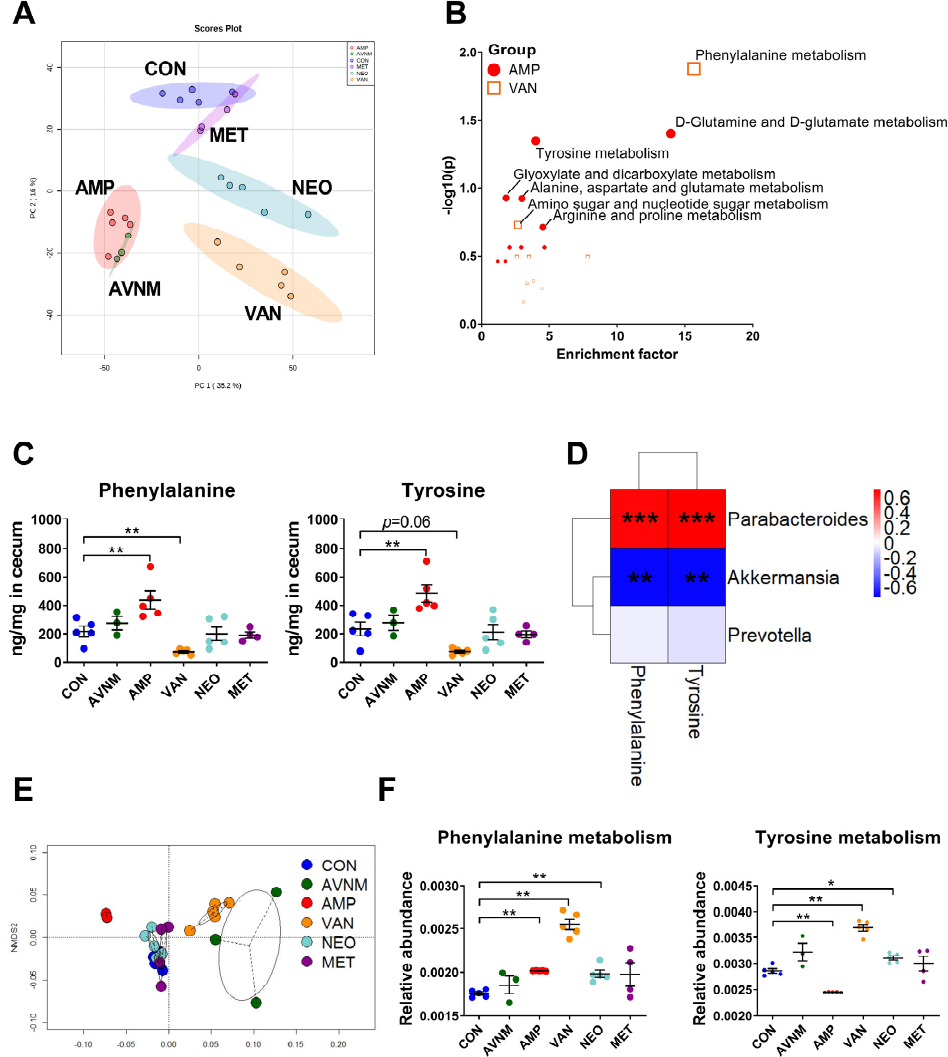
Figure 3. Effects of antibiotic treatment on gut metabolites and correlation with the gut microbiota. ( A ) The principal component analysis (PCA) score plot of untargeted mass spectrometry data in cecal contents of each group. ( B ) Enriched pathway in cecal metabolite of AMP and VAN group. ( C ) The quantity of phenylalanine and tyrosine in cecal content. ( D ) The Spearman’s correlation analysis between relative abundance of major discriminative taxa and the quantity of amino acids in significantly enriched pathways in AMP and VAN group. ( E ) NMDS plot of the predicted function of fecal microbiota with Bray–Curtis distance. ( F ) The relative abundance of predicted function of phe- nylalanine and tyrosine metabolism in fecal microbiota. Data are expressed as the mean ± SEM. Asterisks indicate a statistically significant difference (* p < 0.05, ** p < 0.01, *** p < 0.001; Mann– Whitney U test and Spearman’s correlation, CON, control; AVNM, mixture of ampicillin, vancomy- cin, neomycin and metronidazole; AMP, ampicillin; VAN, vancomycin; MET, metronidazole).